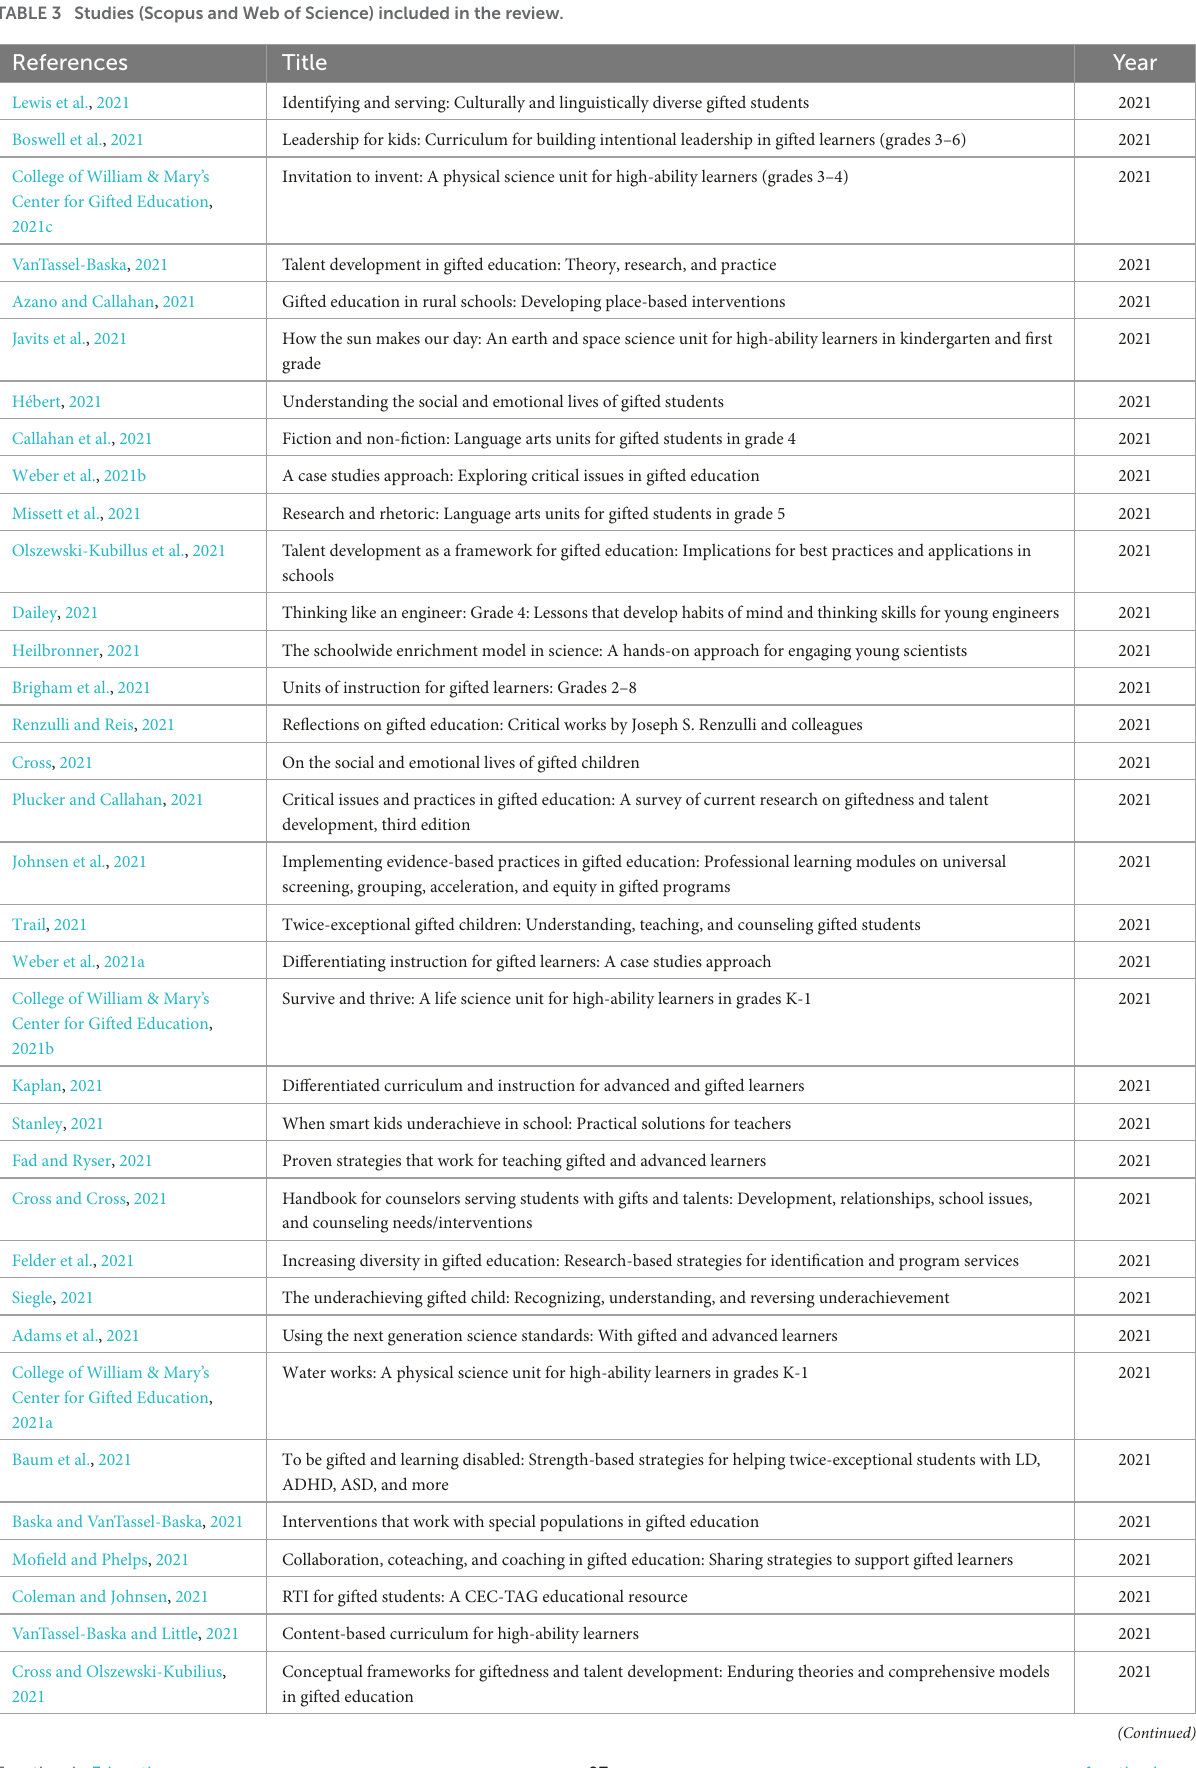
TABLE 3 Studies (Scopus and Web of Science) included in the